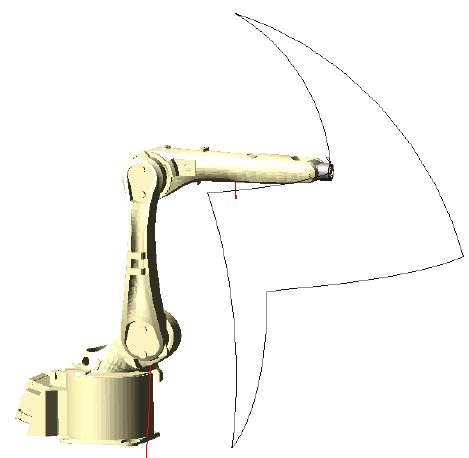
Figure 10. Simulation trajectory of robot end ‐ effector.